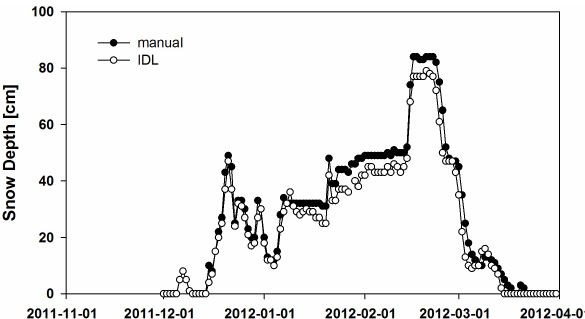
Fig. 4. Comparison between the manually derived snow depths and the results from a semi-automated IDL